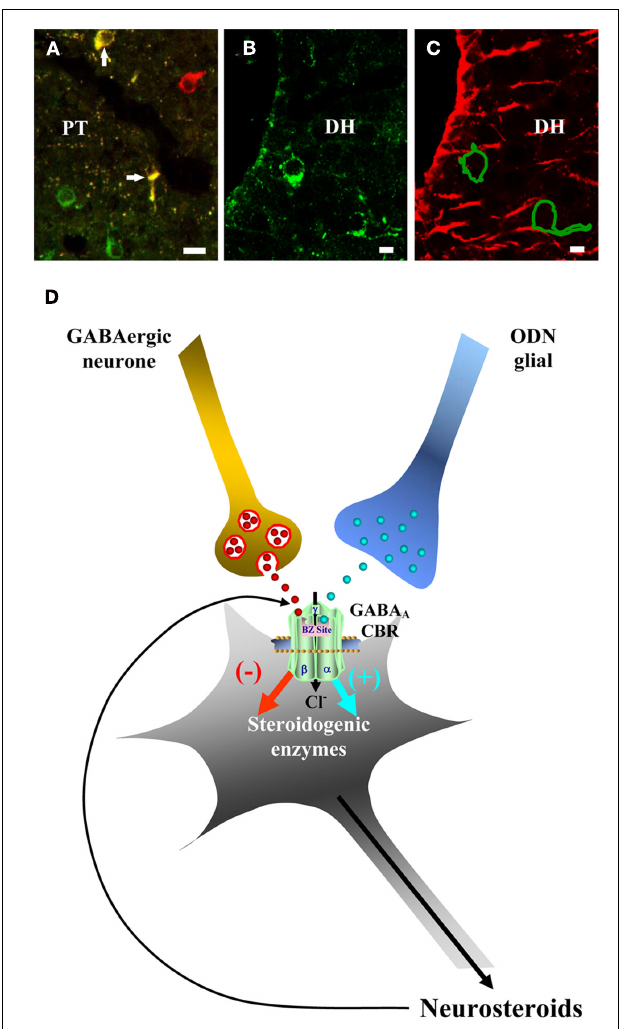
FIGURE 1 | Effect of GABA and the octadecaneuropeptide ODN on neurosteroid biosynthesis. (A) Immunohistochemical localization of 3 β -HSD-like immunoreactivity (red) and GABA A receptor β 2 / β 3 subunit-like immunoreactivity (green) in the posterior tuberculum (PT) of the frog brain. 3 β -HSD-positive neurons that possess GABA A receptor β 2 / β 3 subunits appear in yellow. (B) Immunohistochemical localization of 3 β -HSD-like immunoreactivity in the dorsal hypothalamic nucleus (DH; green). (C) Consecutive section to B showing the immunohistochemical localization of ODN-like immunoreactivity in glial cells bordering the third ventricle (red). The contours of two 3 β -HSD-positive neurons labeled in B are shown. For details regarding antibodies and immunohistochemical procedures, see references by Malagon et al. (1992a) and Do Rego et al. (2000, 2001). In brief, polyclonal antibodies raised in rabbit were used to label 3 β -HSD-containing neurons, a mouse monoclonal antibody was used to label GABA A receptor β 2 / β 3 subunit-expressing cells, and polyclonal antibodies raised in rabbit were used to label ODN-immunoreactive glial cells. Scale bars: 10 μ m. (D) Schematic drawing depicting the effects of GABA and ODN on steroidogenic neurons. GABA acting through GABA A receptors, inhibits the biosynthesis of neurosteroids, while the endozepine ODN, released by glial fibers, acting as an inverse agonist on central-type benzodiazepine receptors (CBR), stimulates the biosynthesis of 17OH- Δ 5 P, DHEA, 17OH-P, and P. Neurosteroids, released by these neurons, may in turn modulate allosterically the activity of the GABA A receptor and thus control their own